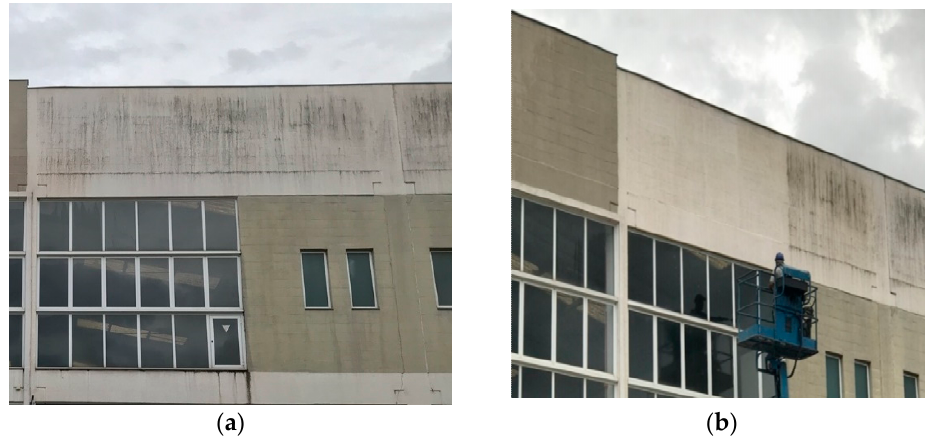
Figure 2. ( a ) Façade before cleaning; ( b ) façade during the cleaning operations with pressurized water jet.